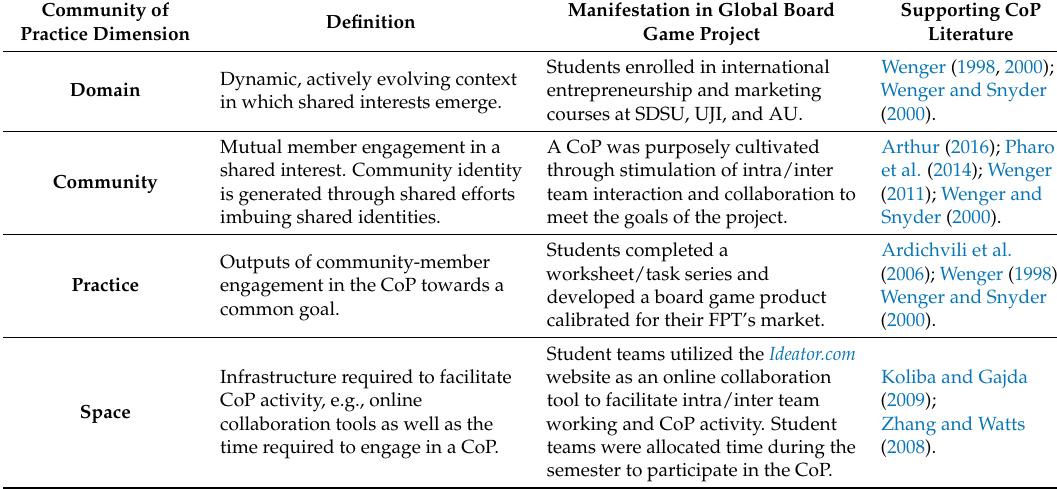
Table 3. Implementation of a Community of Practice model in the Global Board Game